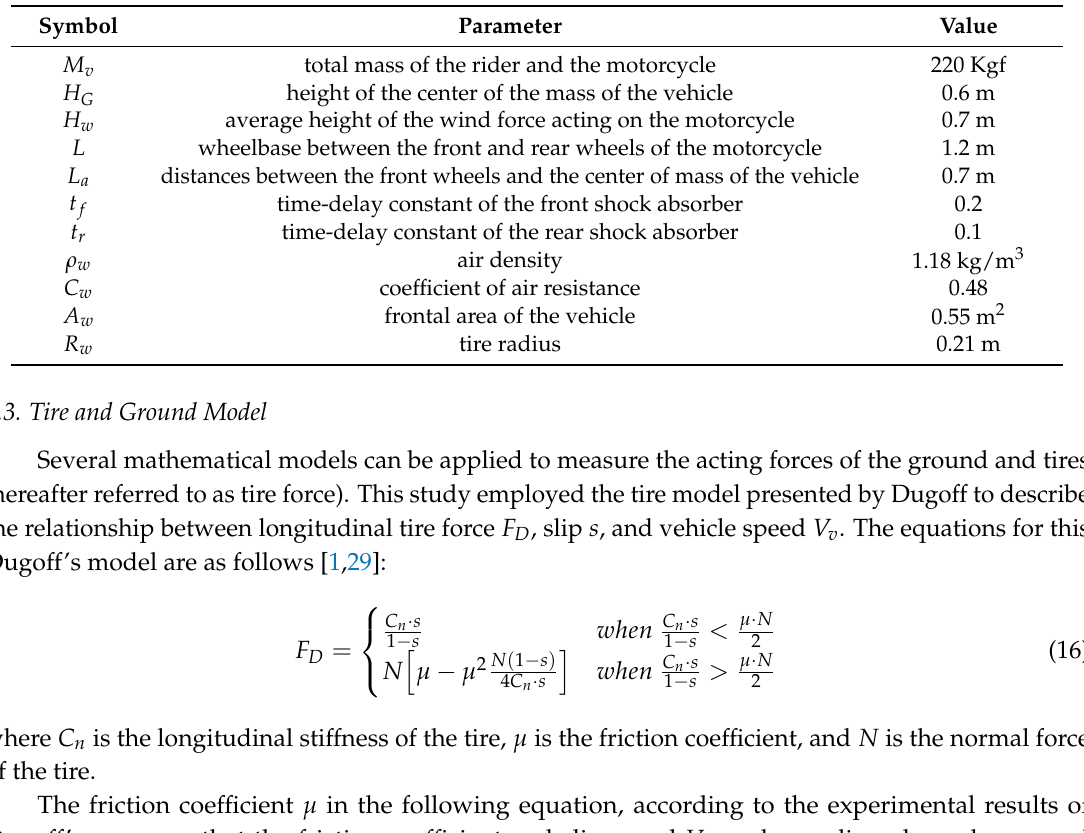
Table 2. The motorcycle motion